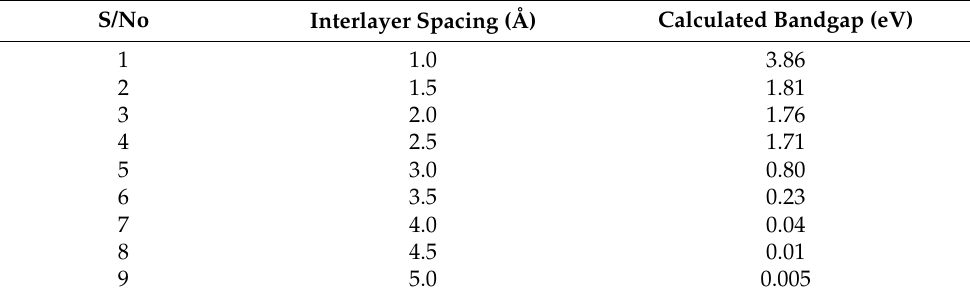
Table 1. Calculated band gaps for h -BN-CNT heterostructures.